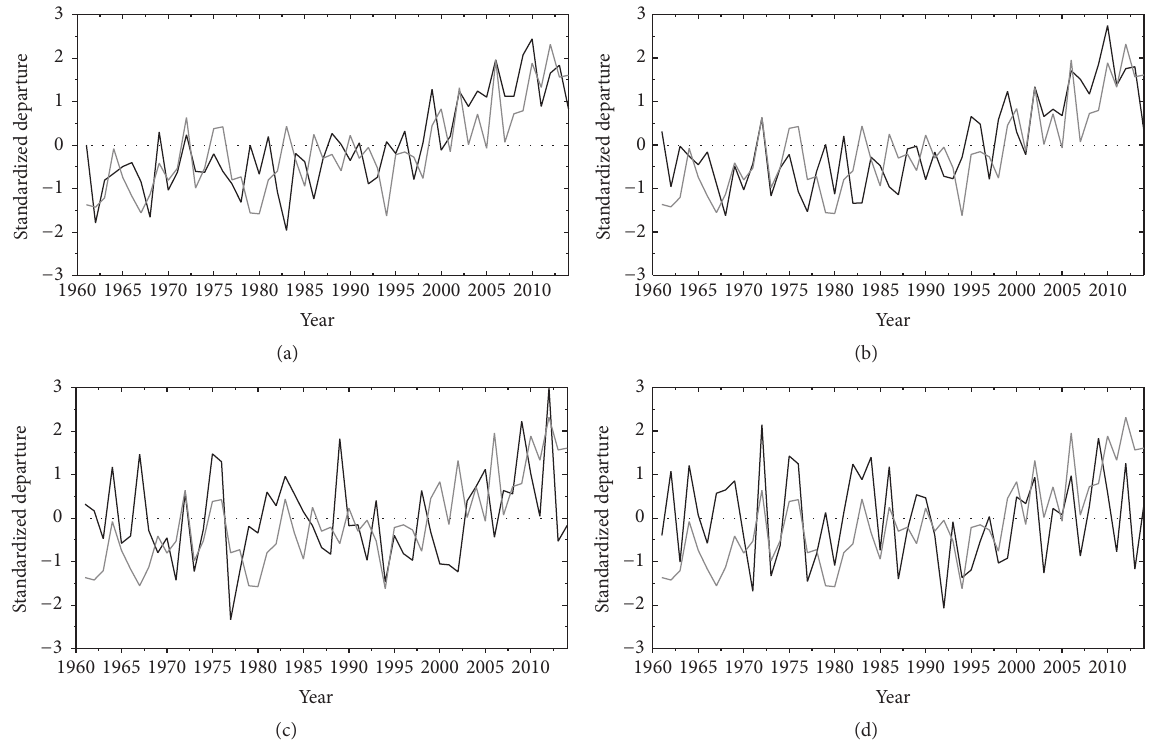
Figure 6: Time series of annual air temperature (a), thawing index (b), annual precipitation (c), and autumn precipitation (d) in TRSR (black line) with the time series of freeze first date (grey line). All variables were standardized with respect to their mean and standard